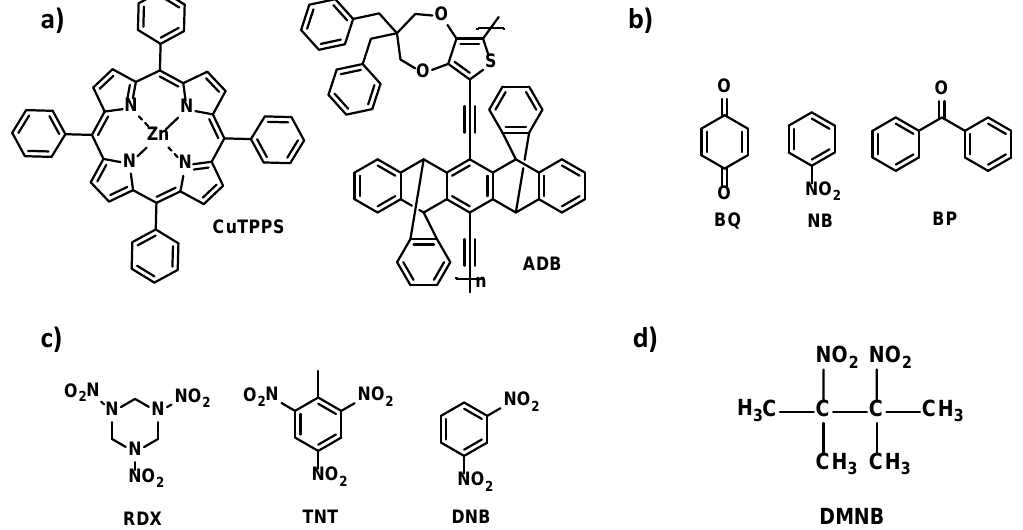
Figure 5. The supposed sensing process of H 2 S in film of polymer PSFDTBT. Both adsorption and desorption speeds of H 2 S molecules increase when the polymer films become thinner. However, desorption speed ( ν d,n ; n = 25, 20, 15, and 5 nm) increases much faster than adsorption speed ( ν a,n ). The length of arrows denotes the level of the